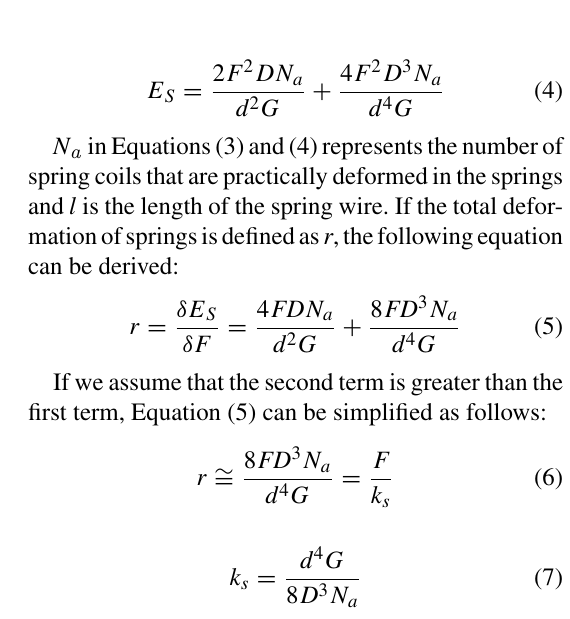
Fig. 4. Motion strategy of the designed exoskeleton system for walking and load-carrying in the field condition.